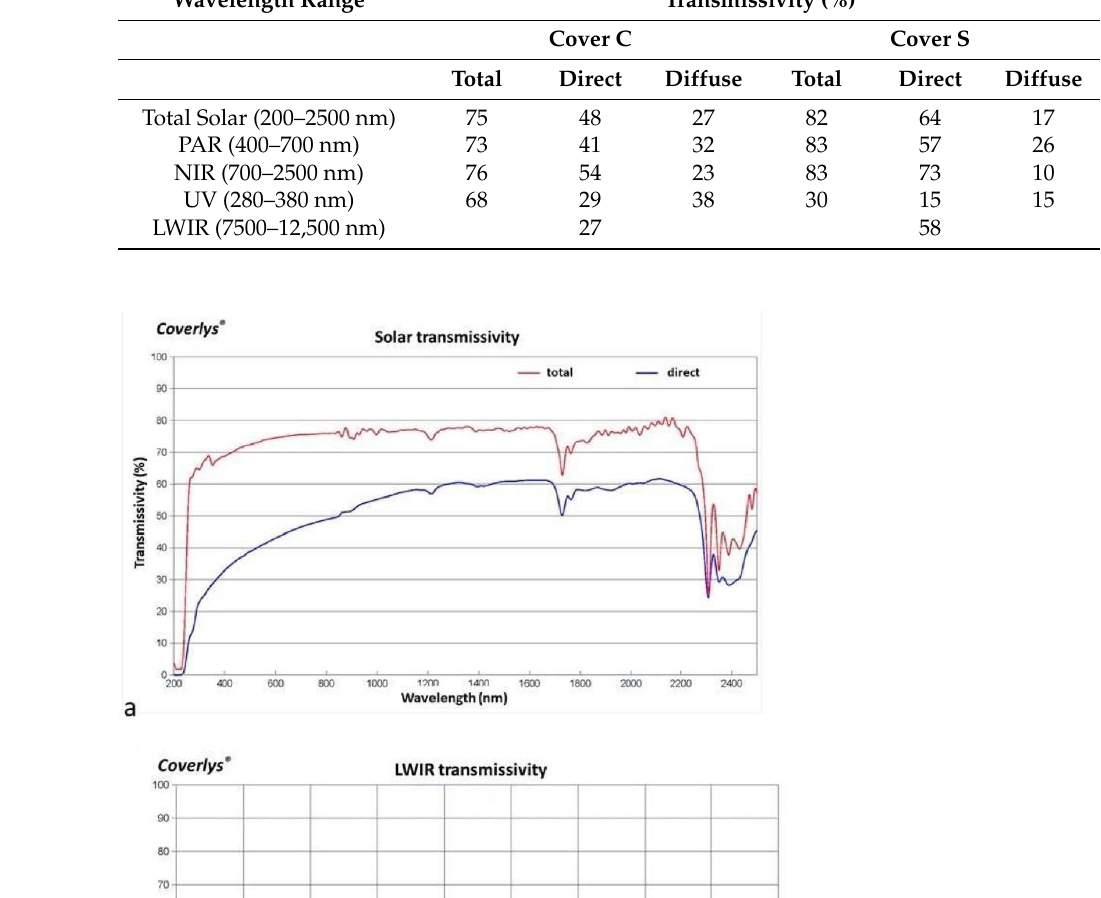
Table 2. Radiometric coefficients of cover C (Coverlys ® agrotextile) and cover S (Serrosol film). Wavelength Range Transmissivity (%)